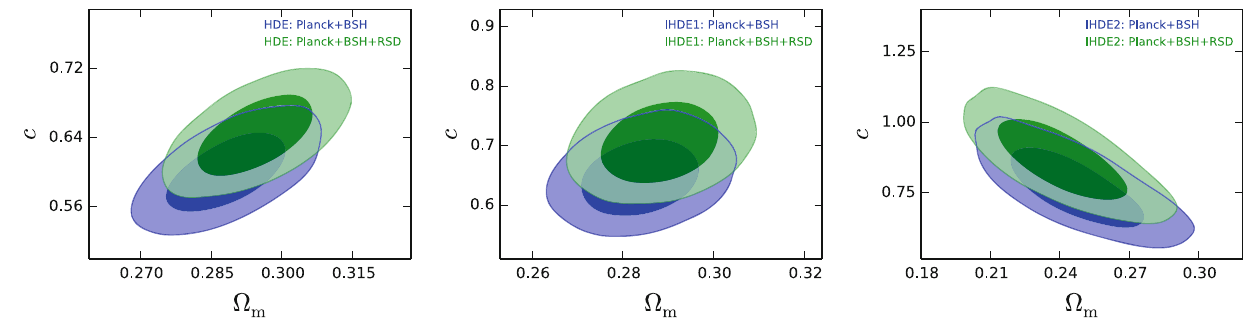
Fig. 1 The two-dimensional marginalized contours (68.3% and 95.4% confidence level) in the (cid:16) m – c plane for the HDE ( Q = 0), IHDE1